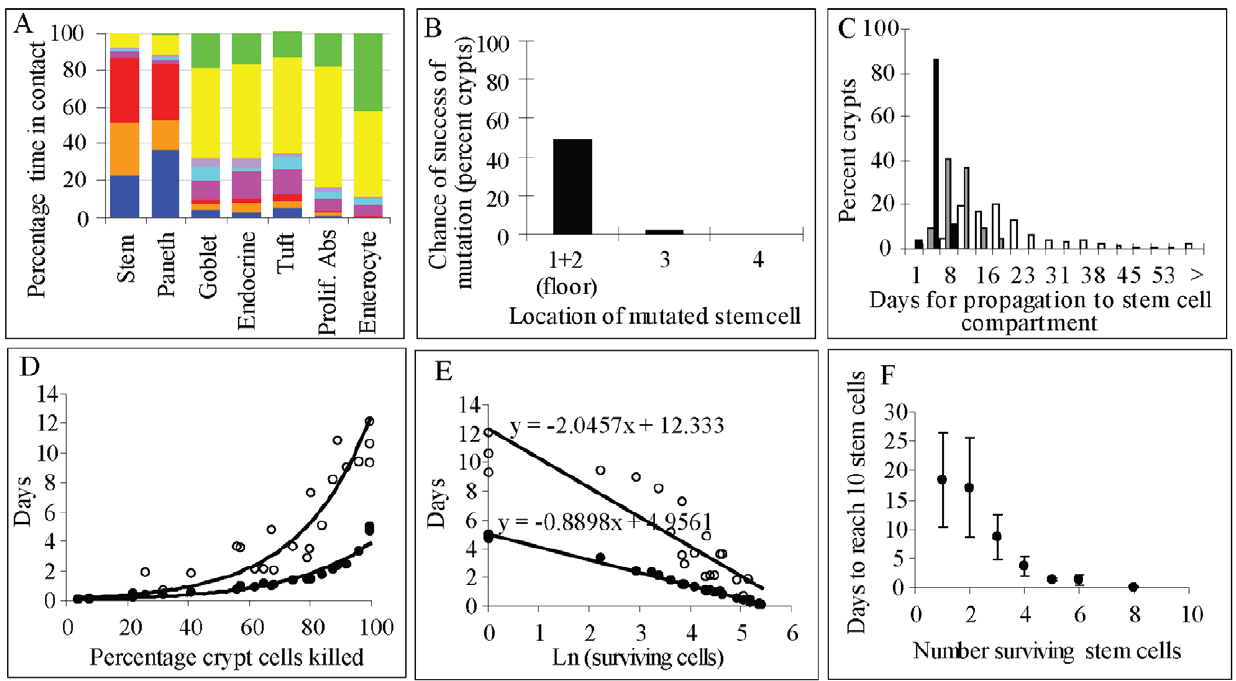
Figure 5. Model Predictions. A) Percentage of contact time between cell types in a mature crypt observed for 80 days. Colour code as in Figure 3. B) The chance of successful propagation of mutations affecting stem cells is , 50% when the mutated cell is on the floor of the crypt and , 2% for locations above. C) The time for the propagation of a mutation to the stem cell compartment is shorter when the mutation decreases the duration of the division cycle. Black columns show time for the propagation of mutated cells with 10-fold shorter division cycle, grey columns for 2-fold shorter, and white columns when division cycle is not affected. D) Time to replenish the crypt with the initial number of cells ( structure of mature crypts after random killing of cells in the crypt ( # ). E) The numerical recovery rate of the injured crypt is 0.78 cells/day. The maturation rate is 0.34 cells/day. The time required to reach the original number of cells for an injured crypt that has lost half of its cells is approximately 0.9 days while the time required to reach a structural steady state is approximately 2 days. F) Time to replenish the bottom of the crypt with 10 Lgr5 hi cells after random killing of stem cells.